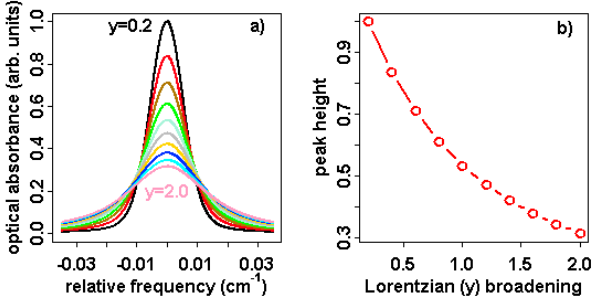
Fig. 4. (a) normalized absorption profiles for constant concentra- tions; (b) correlation between peak height and Lorentzian ( y ) broad-